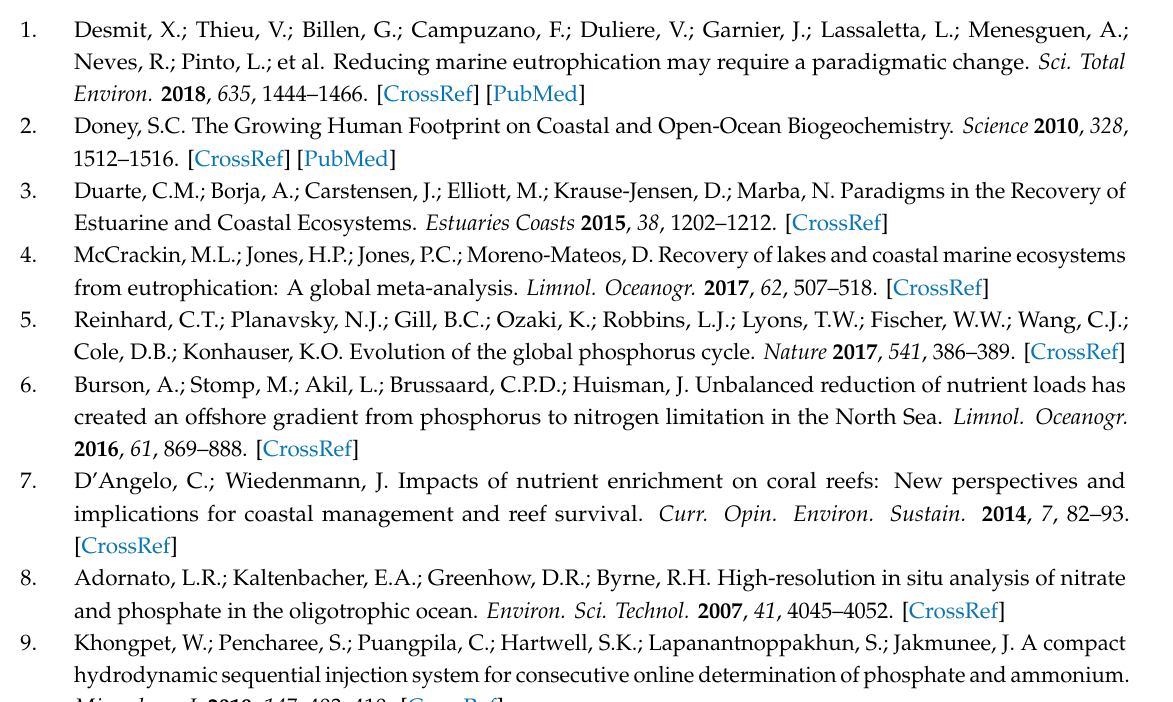
push speeds, Figure S2: R 2 values of curve fittings for di ff erent T1:T2 ratios and a total reaction time of 120 s, Figure S3: R 2 values of curve fittings for di ff erent reaction coil lengths and IDs, Figure S4: R 2 values of curve fittings for di ff erent sample-to-reagent ratios, Figure S5: R 2 values of curve fittings for di ff erent salinities, Figure S6: Comparison of the analyzer and spectrophotometer detection results, Figure S7: Locations of the stations on the two cruises. ( A ): “Healthy Ocean” cruise; ( B ) “Instrument Acceptance”